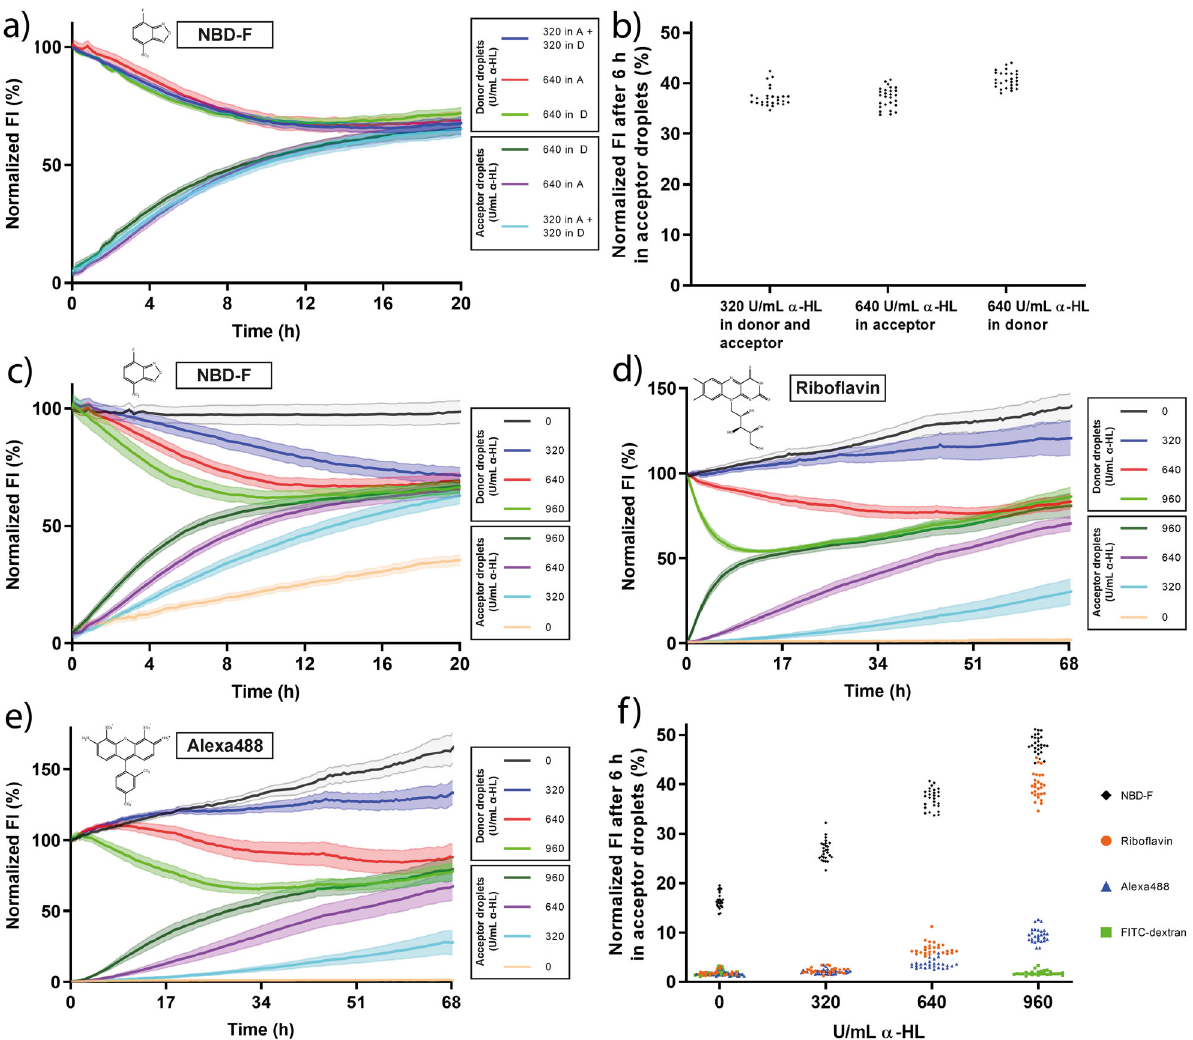
Fig. 3 Translocation of NBD-F, ribo fl avin, and Alexa488 across alpha-hemolysin ( α -HL) pores. a Mean fl uorescence intensity (FI) over time of 300 µ M NBD-F translocation across α -HL pores from donor (D) to acceptor (A) droplets. Comparison of 640 U/mL α -HL in acceptor, 640 U/mL α -HL in donor, or 320 U/mL α -HL in acceptor and donor droplets. Data were collected every ~15 min, n = 27 droplet networks for every curve. b Mean FI of NBD-F after 6 h in the acceptor droplets. c – e Mean FI over time for translocation of the fl uorophores NBD-F (300 µ M, c ), ribo fl avin (60 µ M, d ), and Alexa488 (60 µ M, e ) at different concentrations of α -HL. Here, the numbers in the labels refer to the α -HL in the acceptor droplets, no α -HL was added to the donor droplets. n = 27 droplet networks for every curve. f Mean FI of 300 µ M NBD-F, 60 µ M ribo fl avin, 60 µ M Alexa488, and 60 µ M FITC-dextran (0 and 960 U/ml α -HL) after 6 h in the acceptor droplets. The error bands represent the standard deviation in all fi gures. The continuous increase in the normalized FI in the experiments can be attributed to slow droplet shrinkage over time. We only normalized to the starting fl uorescence of the individual donor droplets and did not account for droplet shrinkage in the data normalization